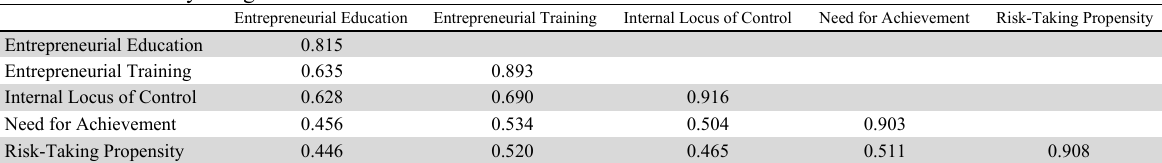
Discriminant Validity using HTMT Ratio